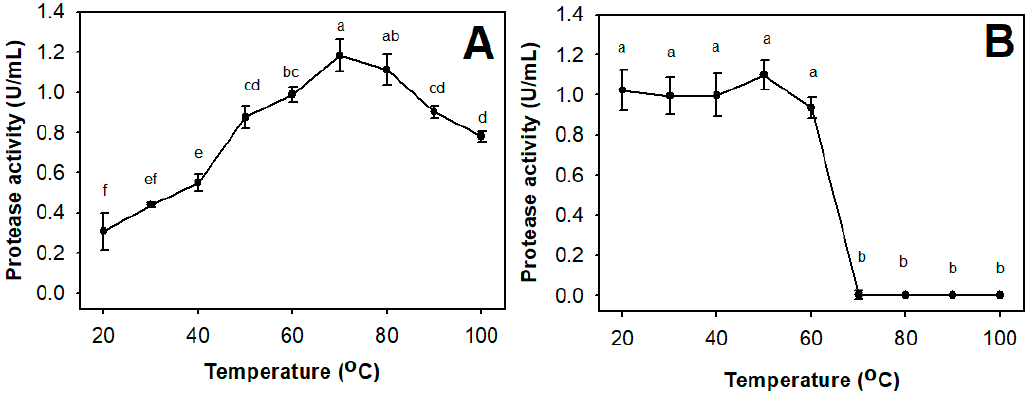
Figure 5. Effect of temperature on the activity ( A ) and stability ( B ) of Paenibacillus sp. TKU047 protease. All points on the graph indicate the mean of each experiment (with n = 3) and standard deviation (error bar). Different letters (a, b, c, d, e, and f) indicate significant difference based on Tukey’s test with p < 0.05.